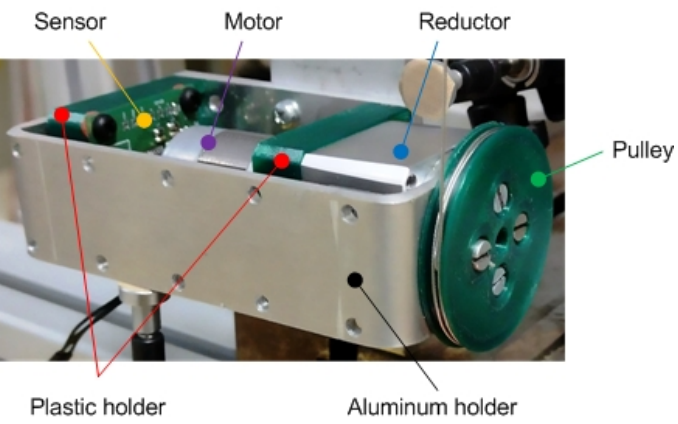
Figure 2. Newly developed actuator A1.